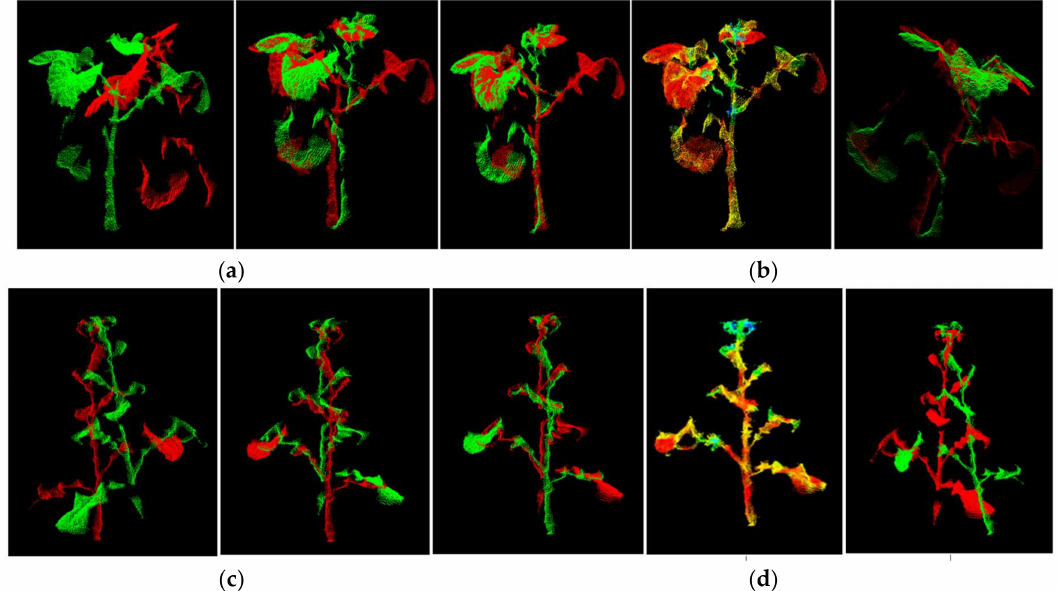
Figure 11. The registration effect of the traditional ICP method and the method in this paper. ( a ) The registration method of this paper. ( b ) Traditional ICP registration. ( c , d ) another set of registration